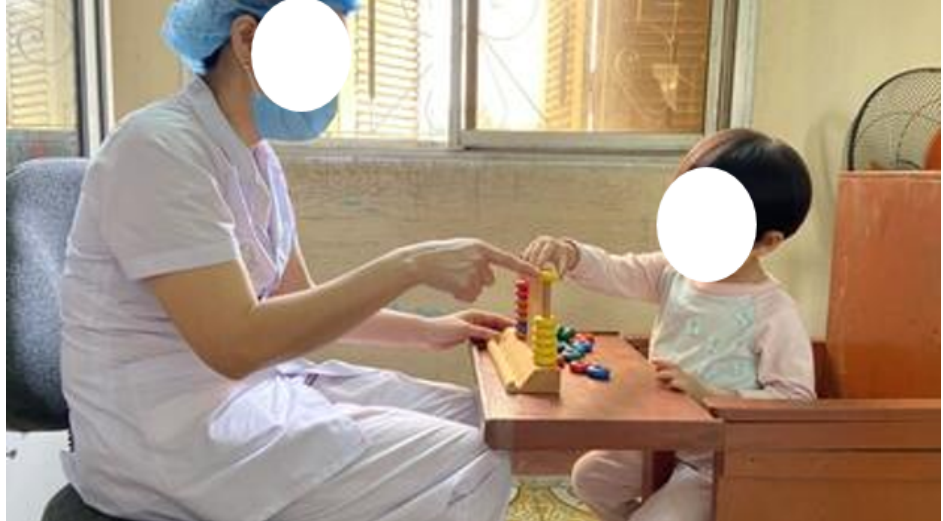
Figure 24. Illustrating the process of the hand rehabilitation exercise